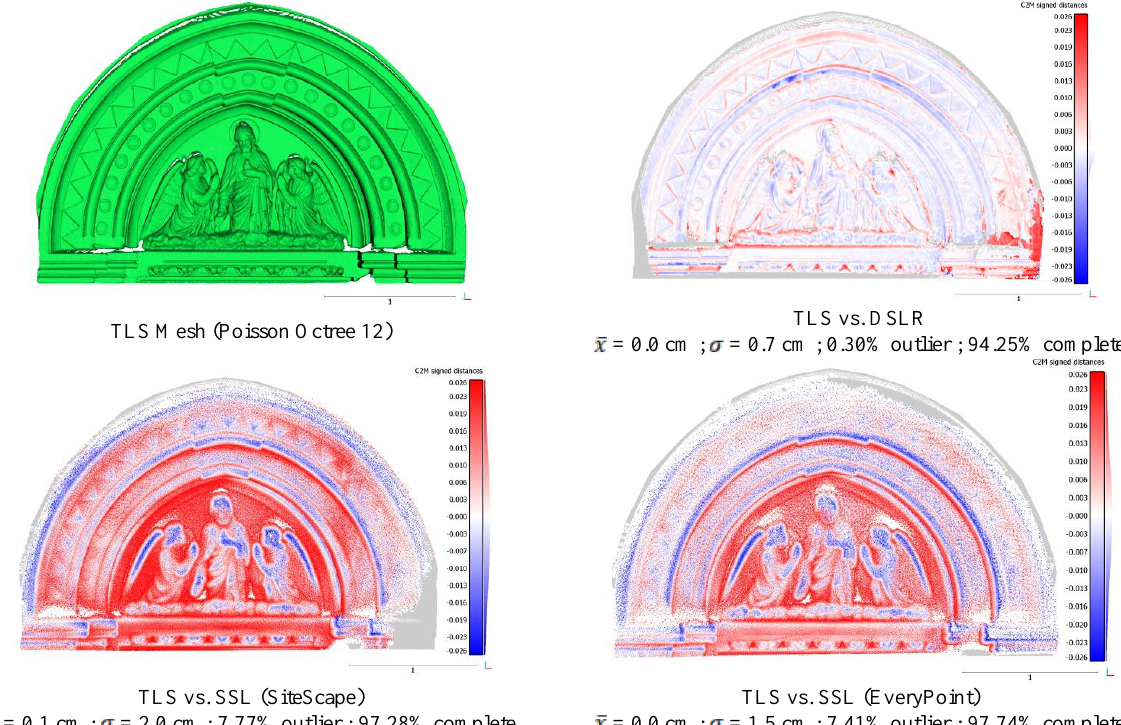
Figure 3. Results and comparison of the tested techniques for case (2). For this figure, the mesh-to-cloud analysis was performed using the TLS mesh as reference data. denotes average deviation in 3D Euclidean distance, denotes standard deviation. Greyed points are outliers and incompletely scanned parts in regards to the TLS Poisson mesh which is considered ideally complete.